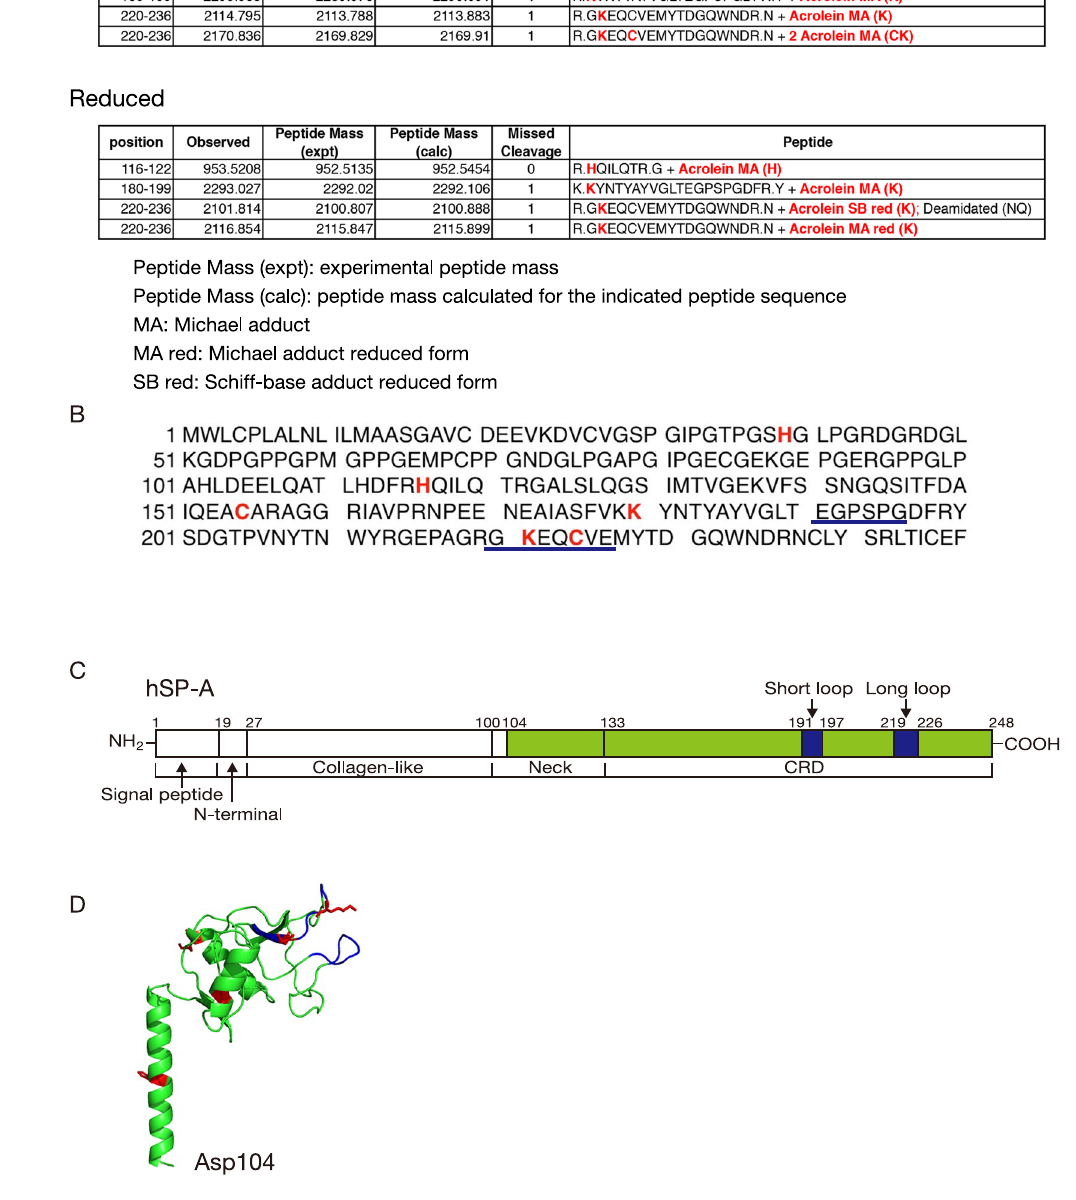
Figure 4. The identification of acrolein-modified residues in SP-A. ( A ) Nano-LC/MALDI-TOF MS/MS analysis of peptides obtained from the trypsin digestion of acrolein-modified hSP-A. Trypsin digested acrolein- modified SP-A was subjected to Nano-LC/MALDI-TOF MS/MS analysis and identified by using MASCOT Daemon. Acrolein-modified residues are shown in red. (Upper) The MS/MS analysis of non-reduced acrolein- modified SP-A. (Lower) The MS/MS analysis of NaBH 4- reduced acrolein-modified SP-A. ( B ) The amino acid sequence of hSP-A. Acrolein-modified residues are shown in red, and the double-loop structure is indicated by the blue underlined text. ( C ) The structural organisation of human SP-A. SP-A is conceptually divided into a signal peptide, N-terminal, collagen-like neck and CRD domain. The double-loop structure in the CRD domain is shown in blue (long loop residues: 219–226 and short loop residues: 191–197). Green corresponds to residues 104–248, which are shown in the crystal structure in ( D ). ( D ) A homology model of the hSP-A neck and CRD domains (residues: 104–248) based on the crystal structure of rat SP-A (PDB ID: 1R13). The model was constructed using SWISS-MODEL 37 . The protein backbone is shown in green, the double-loop structure in the CRD domain is shown in blue, and acrolein-modified residues are highlighted in